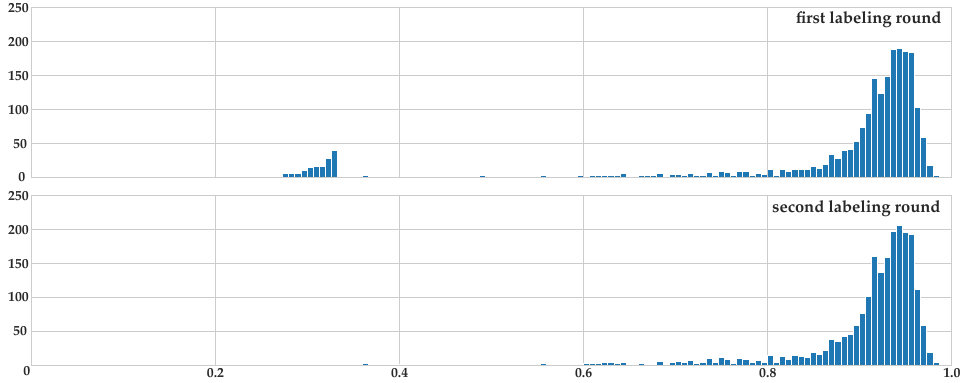
Figure 3. Accordance rate after first ( top ) and second ( bottom ) labeling round. The peak at R ≈ 0.33 in the first labeling round is due to instances where only two of three experts found an animal, resulting in R ≈ 0.33 when the pairwise agreement is computed. The same is true for the instances where all three experts found the same animal, but only two assigned the same identity. After the second collaborative round, this peak almost vanishes, implying a very high consistency in annotation for the dataset. Please note that instances without any animal (resulting in R = 1) were excluded from this graph for a clearer